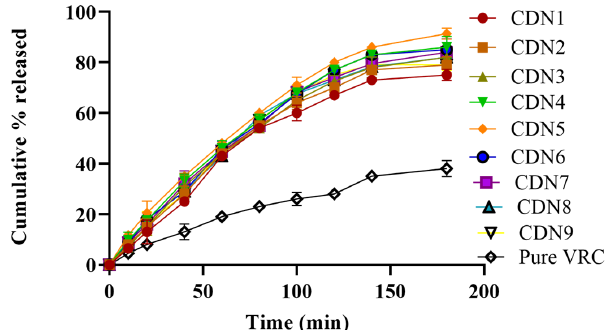
Figure 9. Effect of pH 6.8 on VRC release.